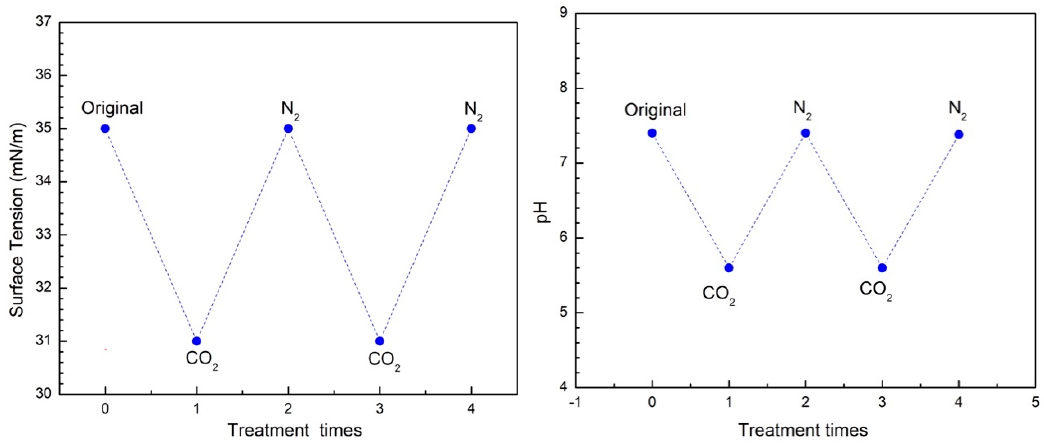
Figure 3. Surface tension (left) and pH value (right) of the aqueous solution of SDS (0.012 mol·L − 1 ) with oligochitosan (0.2 wt.%) at 25 ± 0.5 °C against time during two cycles of sparging CO 2 and N 2 .